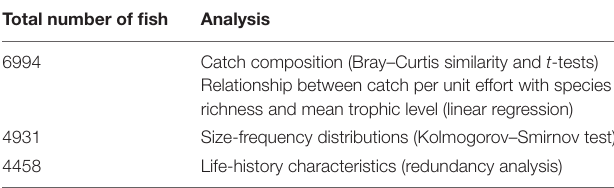
TABLE 1 | Sample sizes (number of individual fish) used for each analysis.